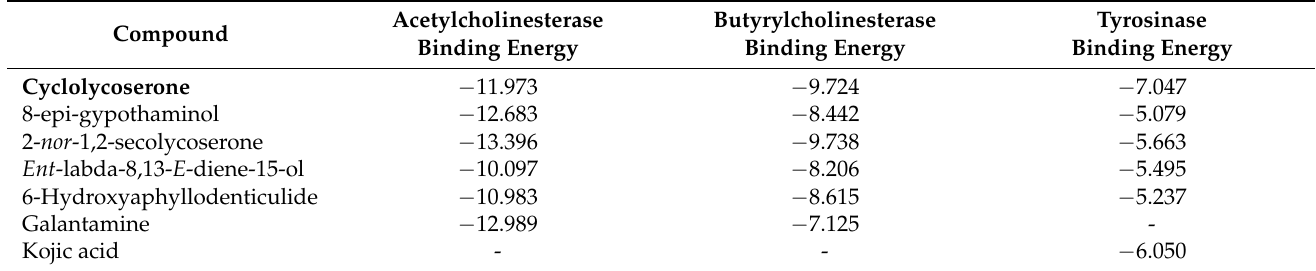
Table 4. Binding energies (kcal/mol) were obtained from docking experiments of major metabolites from the G. pinifolium n-hexane and ethyl acetate extracts, as well as the known inhibitors